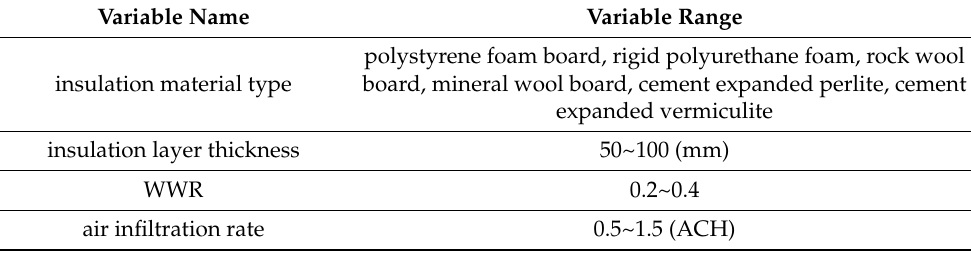
Table 6. Key design variable ranges.